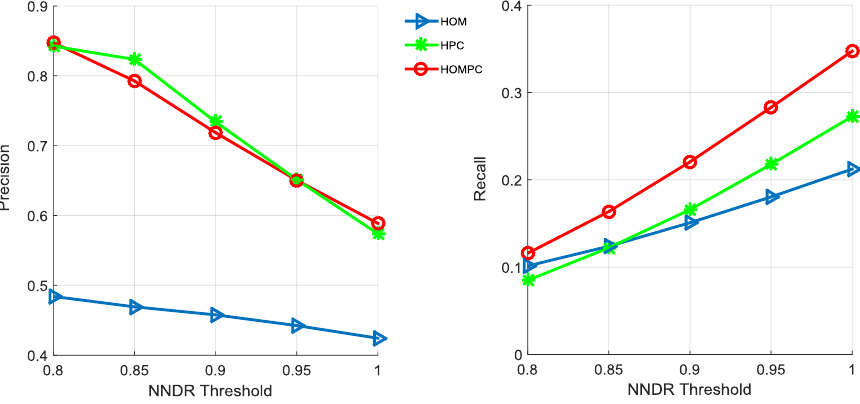
Figure 11. The average precision and recall curve results with different thresholds for HOMPC, HPC, and HOM.